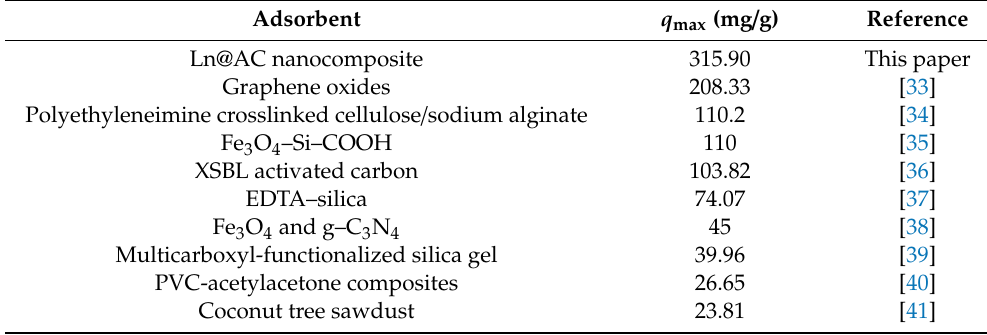
Table 4. The q max values for the adsorption of Zn(II) on different adsorbents.